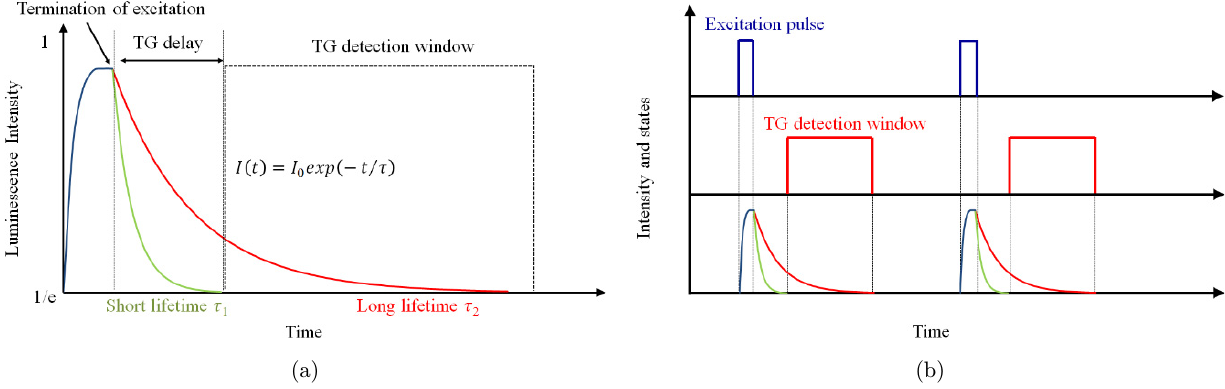
Fig. 1. (a) Illustration of TG detection in one cycle. (b) Illustration of TG detection by acquisition over multiple